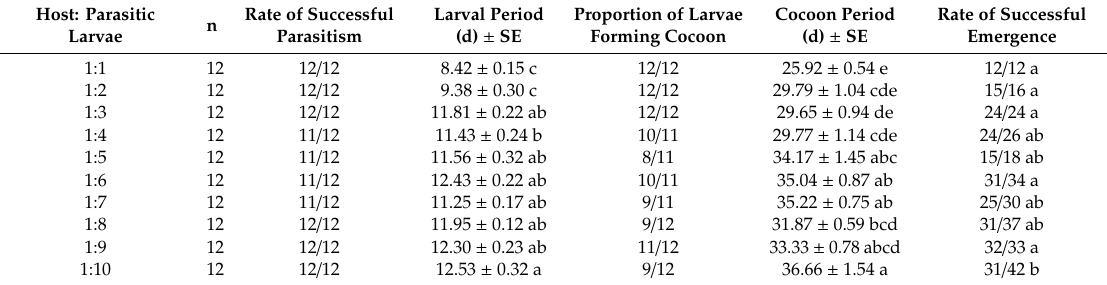
Table 1. The developmental performance of D. helophoroides larvae with various densities. Data in the table refer to mean ± SE. Di ff erent letters within a column indicate significant di ff erences among treatments ( p <